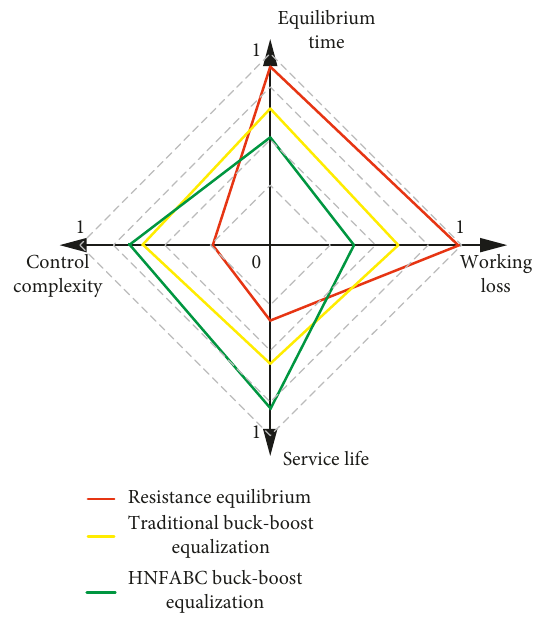
Figure 12: Multidimensional comparison equalization strategy